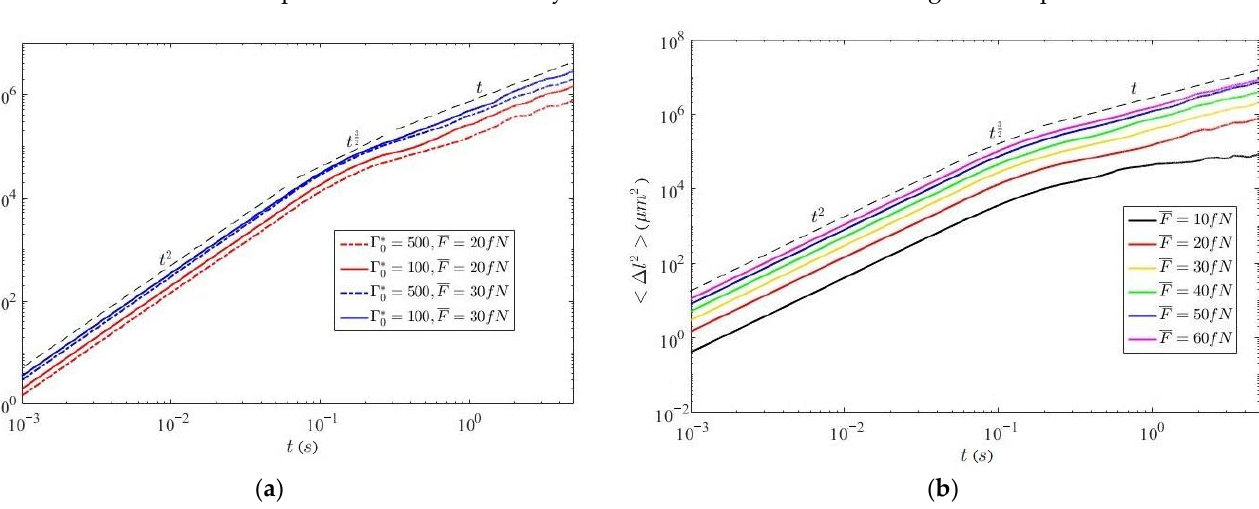
Figure 3. ( a ) Mean square displacements of particles at Г* 0 = 100 и 500, and with different values of thermophoretic force 𝐹̅ . ( b ) Mean square displacements of particles at the initial value of the effective parameter of nonideality Г *0 = 500 and various values of thermophoretic force 𝐹̅ .